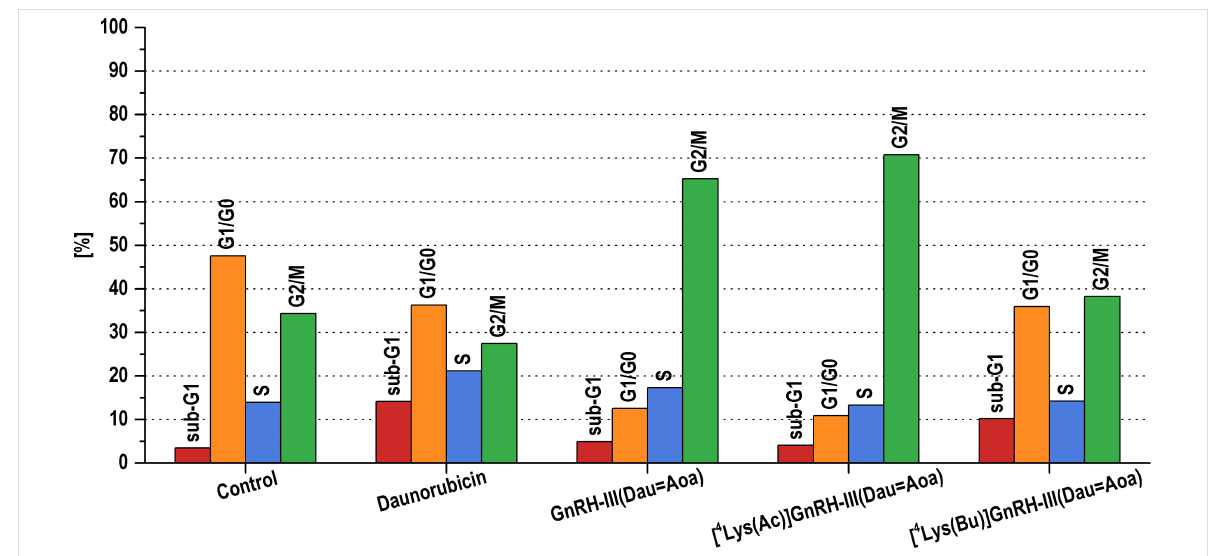
Figure 4: Effects of conjugates and daunorubicin (Dau) on cell cycle progression of A2058 melanoma cells. The model cell was incubated with the compounds at 10 − 5 M concentration for 24 h. Results are expressed as a percentage of cells in the sub-G1 area and the major phases (G1/G0, S and G2/M) of the cell cycle. Data shown in the figure represent mathematical averages of two parallel